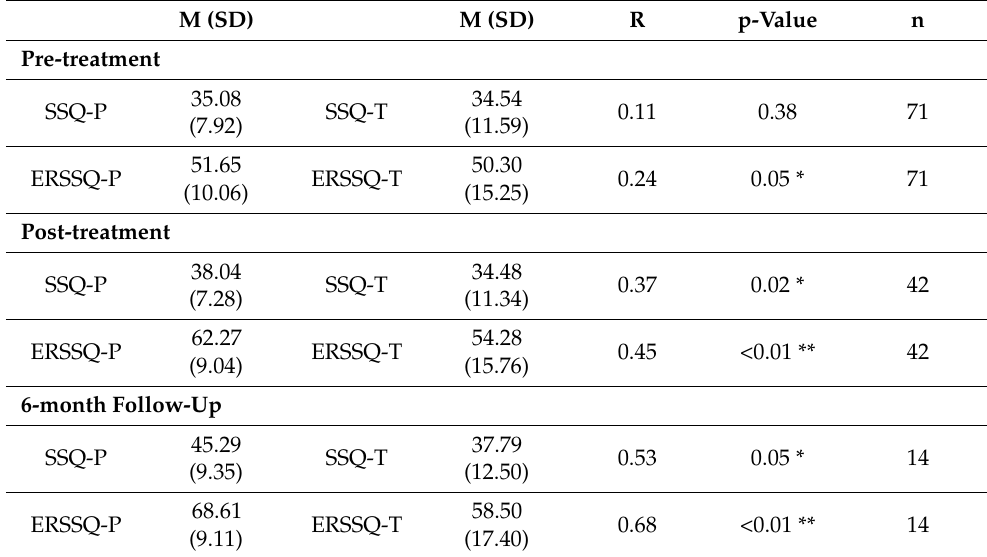
Table 3. Correlation coefficients between parent- and teacher-report measures of children’s social- emotional functioning at pre-treatment, post-treatment, and at 6-month follow-up.